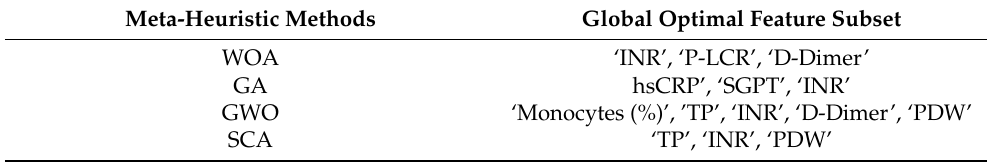
Table 4. A list of features was obtained using the four state-of-the-art meta-heuristic methods. Meta-Heuristic Methods